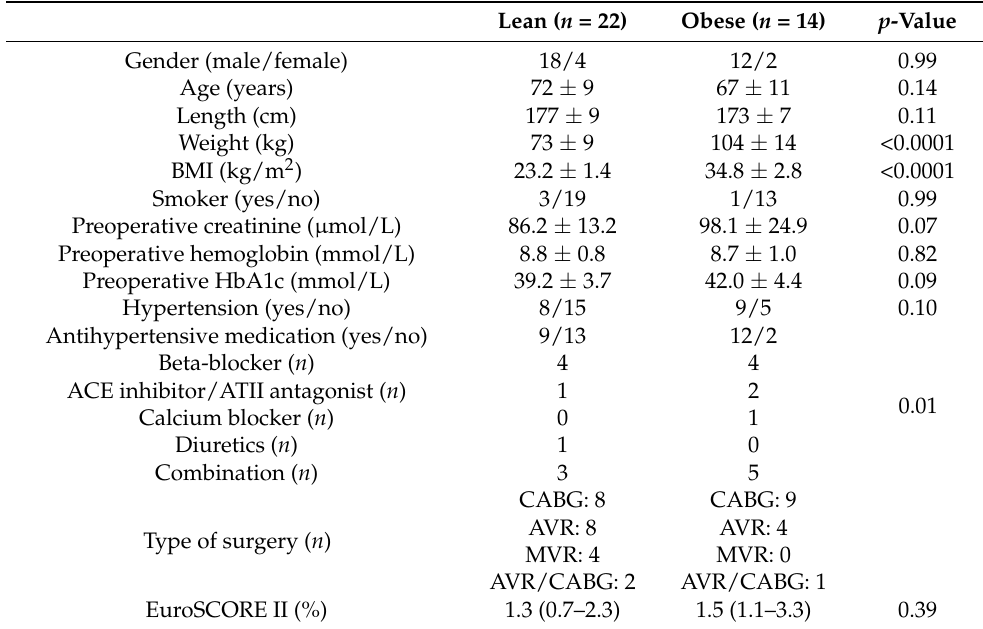
Table 1. Patient